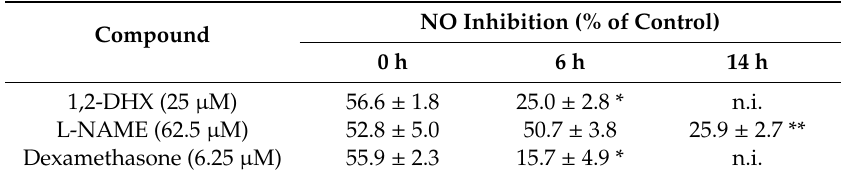
Table 2. Inhibitory e ff ect of 1,2-dihydroxyxanthone (1,2-DHX) on nitric oxide (NO) production by RAW 264.7